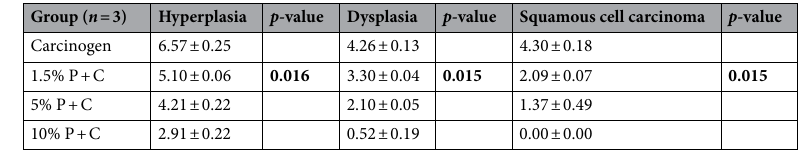
Table 2. Effect of pre and concurrent treatment of PBPs on microscopic hamster buccal pouch tumor multiplicity and area. Represented as Mean ± standard deviation, Kruskal–Wallis test applied. The number of each proliferative lesion assigned by pathologists were counted in each tile scan (50 microns apart). The total number of each proliferative lesion type was counted in every tile scan of each hamster and expressed as an average number of each type of lesion per hamster.